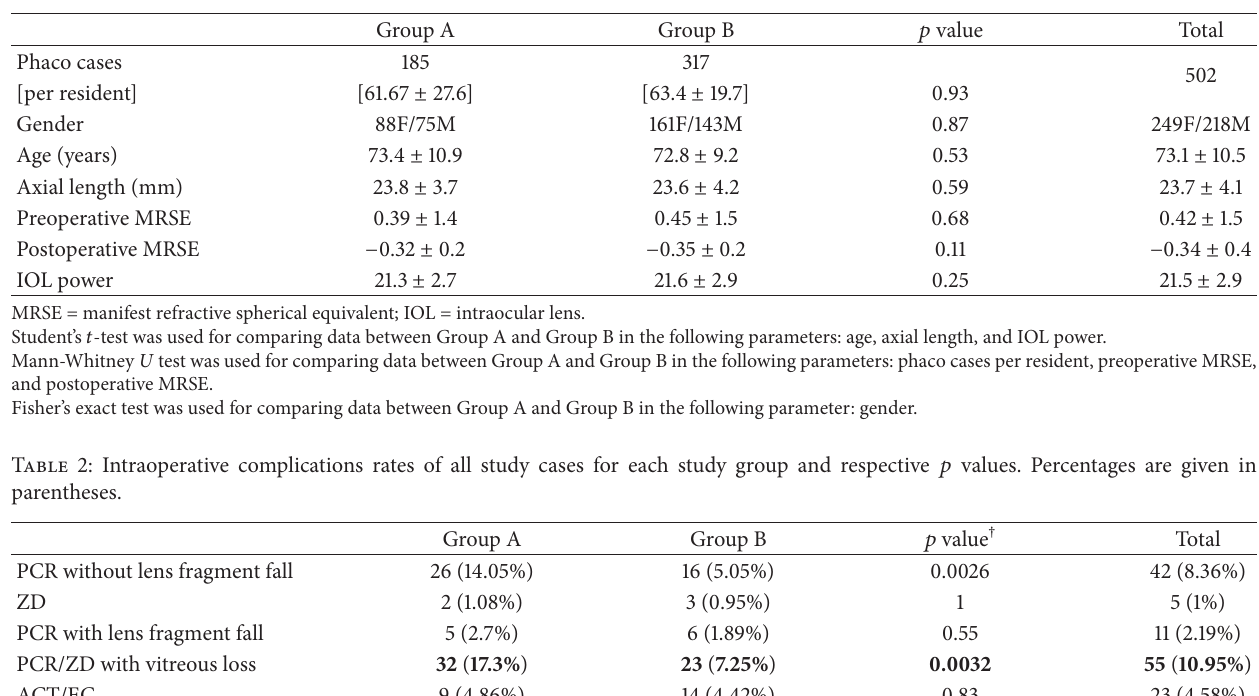
Table 1: Main demographic and clinical characteristics data.